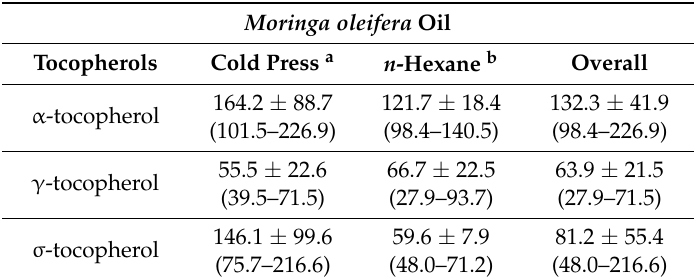
Table 5. Tocopherol content (mg/kg) of Moringa oleifera